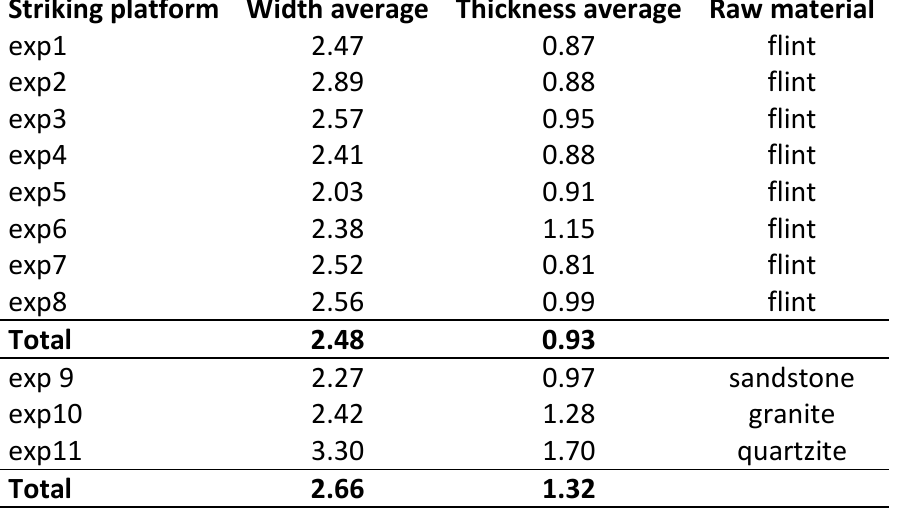
Table 3. Average sizes of striking platforms for flakes produced with flint